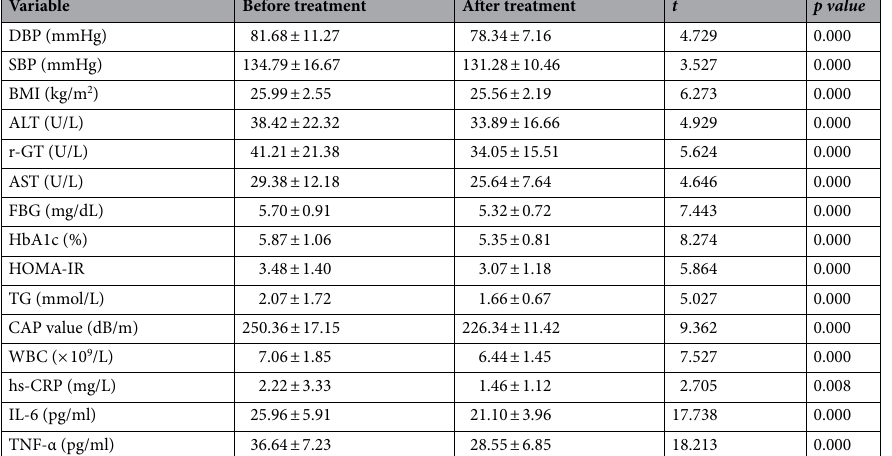
Table 2. Comparison of therapeutic effects before and after treatment in the treatment group. SBP systolic blood pressure, DBP diastolic blood pressure, BMI body mass index, WBC white blood cell, ALT alanine aminotransferase, γ-GT γ-glutamyltranspeptidase, AST aspartate aminotransferase, hs-CRP high-sensitivity C-reactive protein, FBG fasting blood glucose, HbA1c glycosylated haemoglobin, HOMA-IR homeostasis model assessment of insulin resistance, TG triglyceride, CAP controlled attenuation parameter, IL-6 interleukin 6, TNF-α tumour necrosis factor-α. * p value obtained from paired t